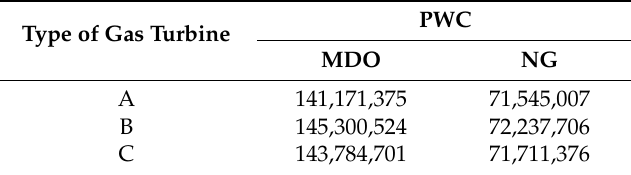
Table 13. Optimal PWC for the six combinations of gas turbines and fuels.